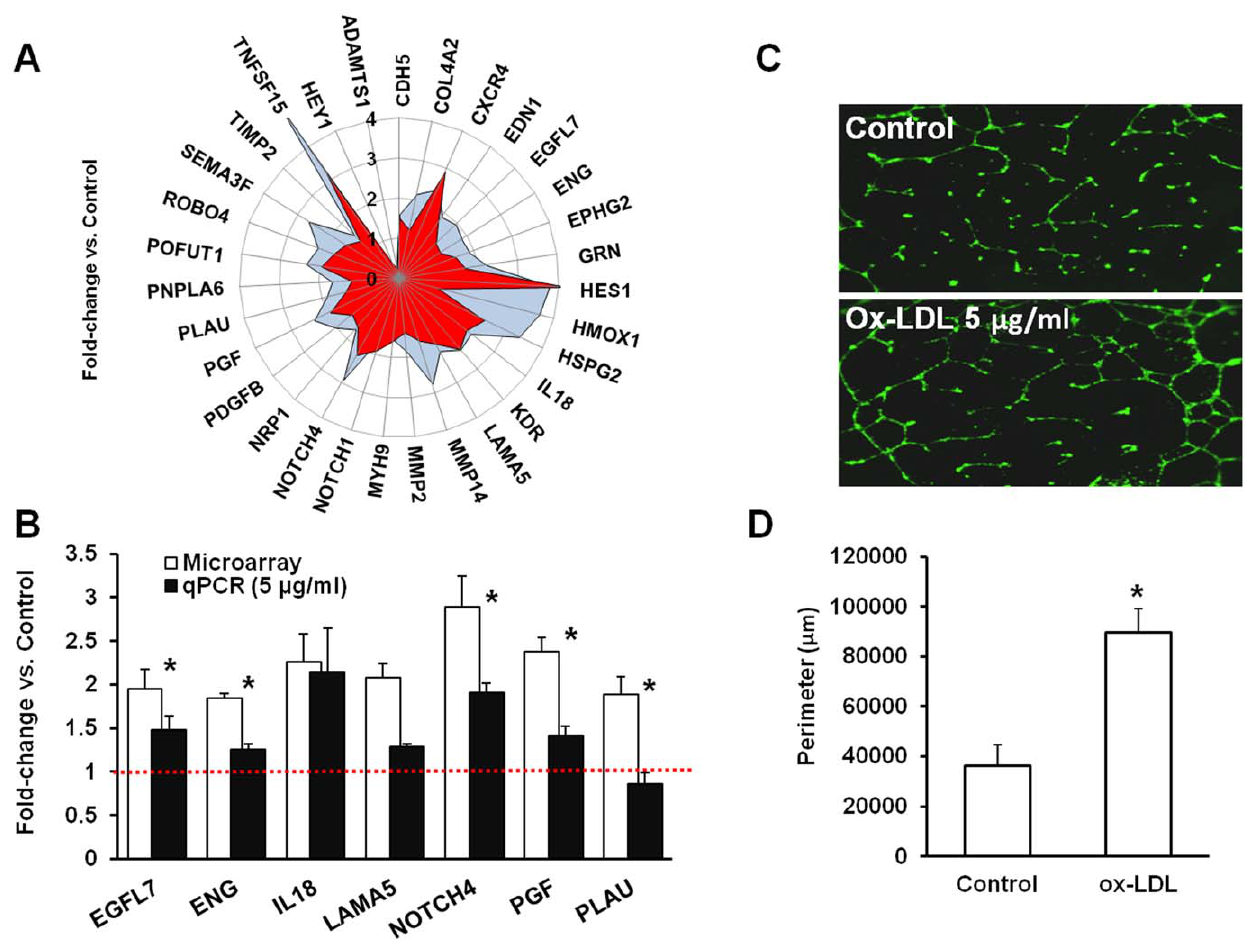
Figure 2. Effects of ox-LDL on genes implicated in angiogenesis. ( A ) - Differentially expressed genes involved in angiogenesis (Blue – exposure to ox-LDL alone; Red- pre-treatment with LOX-1 antibody followed by exposure to ox-LDL; ( B ) - validation of microarray data on select genes (white bars) by qPCR (black bars); ( C ) – tube formation on matrigel by HCAECs in presence of 5 m g/ml ox-LDL (16 hrs); ( D ) - Graph summarizing data on matrigel